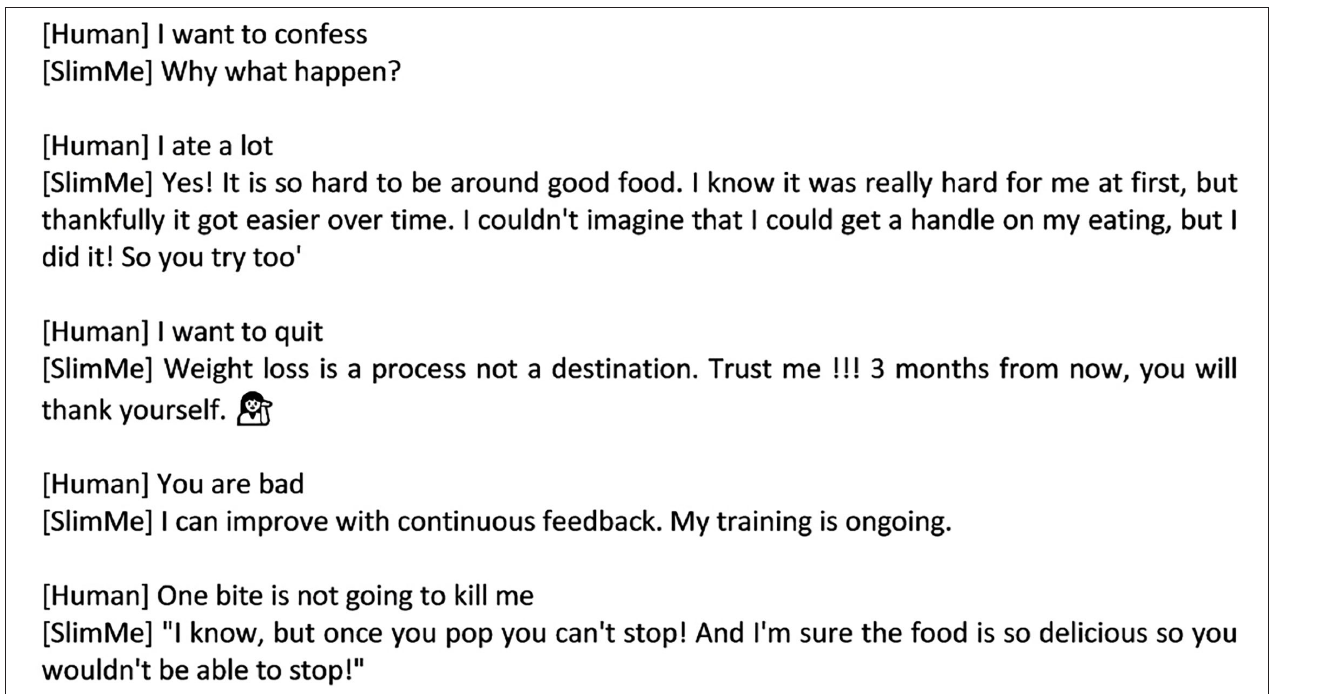
(35). A detailed explanation of the TEE and BMR calculations can be seen in Supplementary File 2